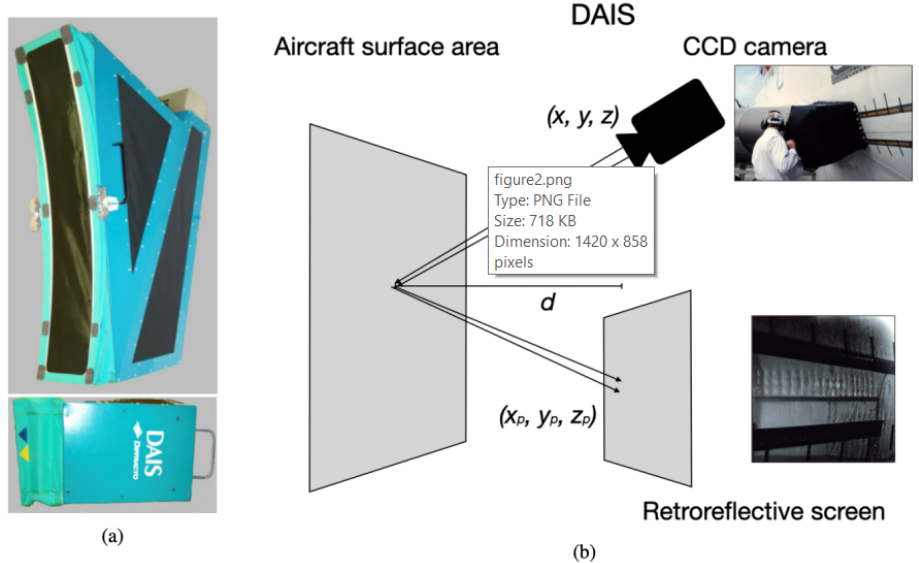
Figure 2. D-Sight Aircraft Inspection System (DAIS). ( a ) DAIS 250c, and ( b ) schematic of DAIS